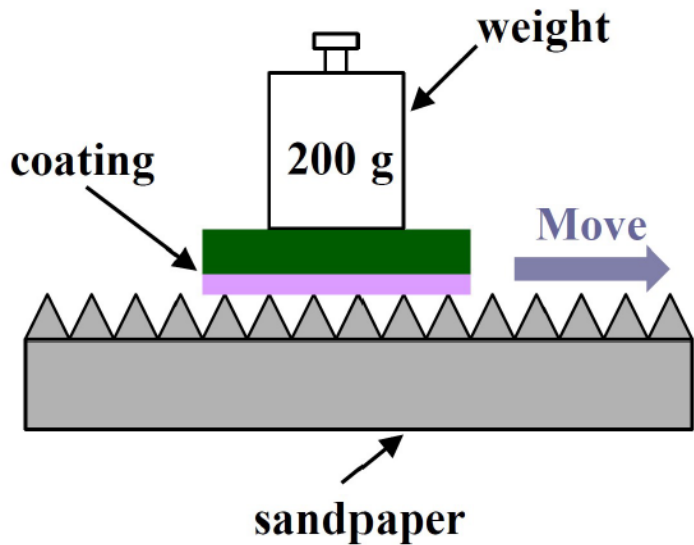
Figure 4. Schematic diagram of the anti-wear experiment.